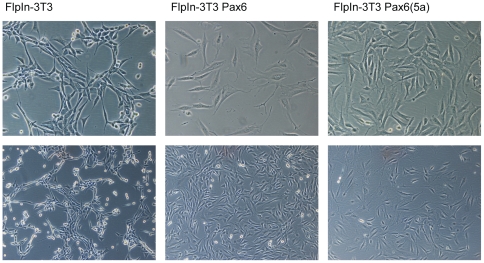
The FlpIn-3T3 Pax6 and FlpIn-3T3 Pax6(5a) cell lines have changed morphology compared to the original FlpIn 3T3 cell line they were generated from.This was repeatedly observed over several passages. Pax6 and Pax6(5a) expressing cells appeared more flattened and seemed to have more protrusions. The cells on the picture have passage numbers 17, 15 and 11 for the FlpIn-3T3, FlpIn-3T3 Pax6 and FlpIn-3T3 Pax6(5a) respectively. For the pictures on the upper row a 20× magnification is used, for the lower row a 10× magnification is used on a Zeizz Axiovert S100 Microscope with a Nikon Digital Sight DS-5 M camera.